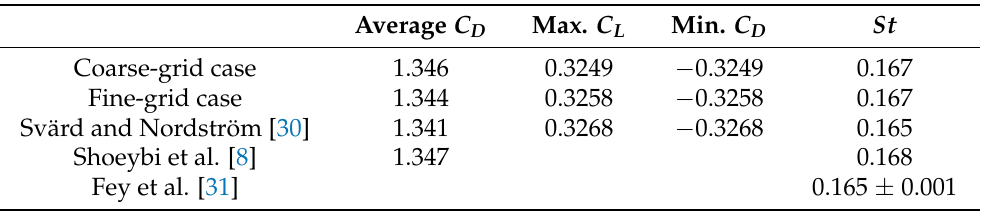
Table 1. Average drag coefficient C D , minimal and maximal values of lift coefficient C L , and Strouhal number St for flow over a two-dimensional circular cylinder at Re D =